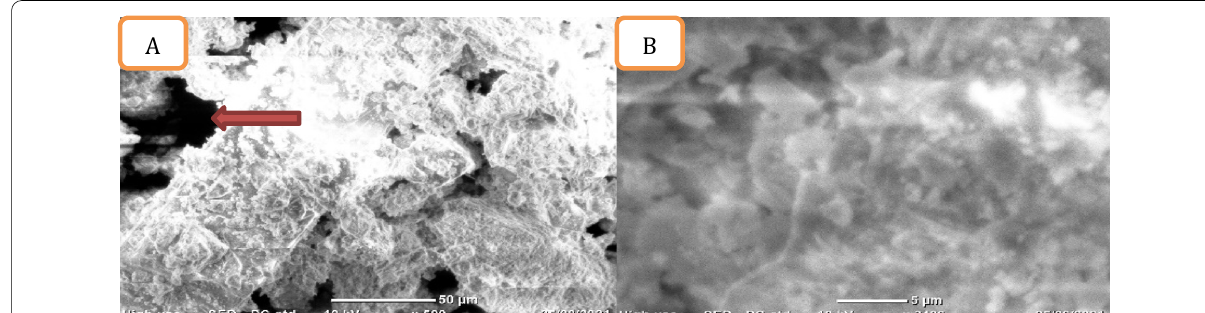
Fig. 10 SEM image of row control mix (100% OPC) at different magnification rate a at magnification rate 50µm, and b at magnification rate 5 µm